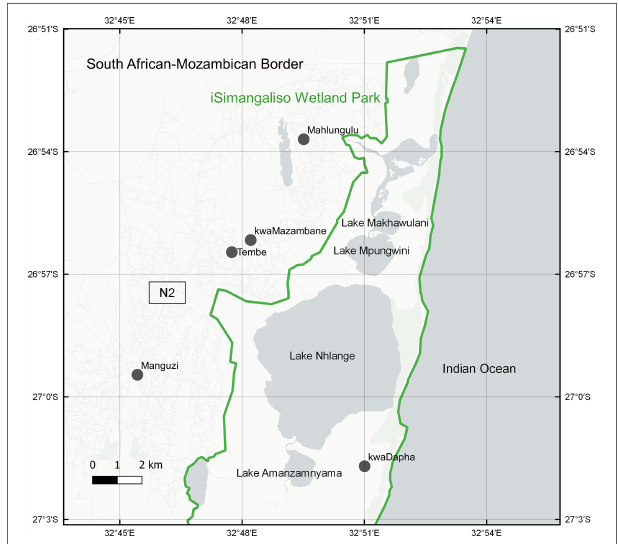
FIGURE 6 | The Kosi Bay system (black border) is made up of the four lakes and the estuary mouth and is situated within the iSimangaliso Wetland Park (green border). The park borders Mozambique to the North. Neighbouring communities are indicated here (grey